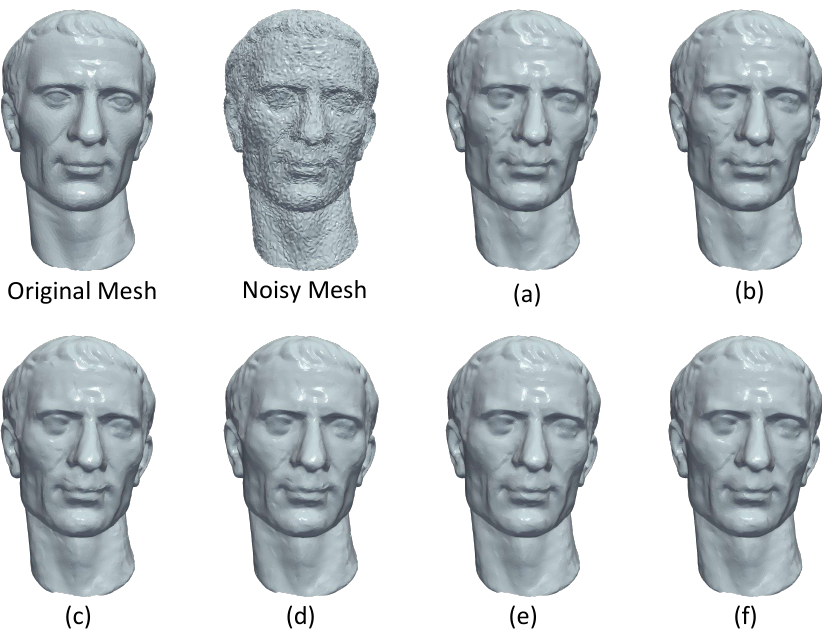
Figure 8. Coarse denoising meshes with 70 equal-sized overlapped submeshes consisting of ( a ) 532 vertices (max), ( b ) 558 vertices (1.05 · max), ( c ) 585 vertices (1.10 · max), ( d ) 611 vertices (1.15 · max), ( e ) 638 vertices (1.20 · max), ( f ) 665 vertices (1.25 ·